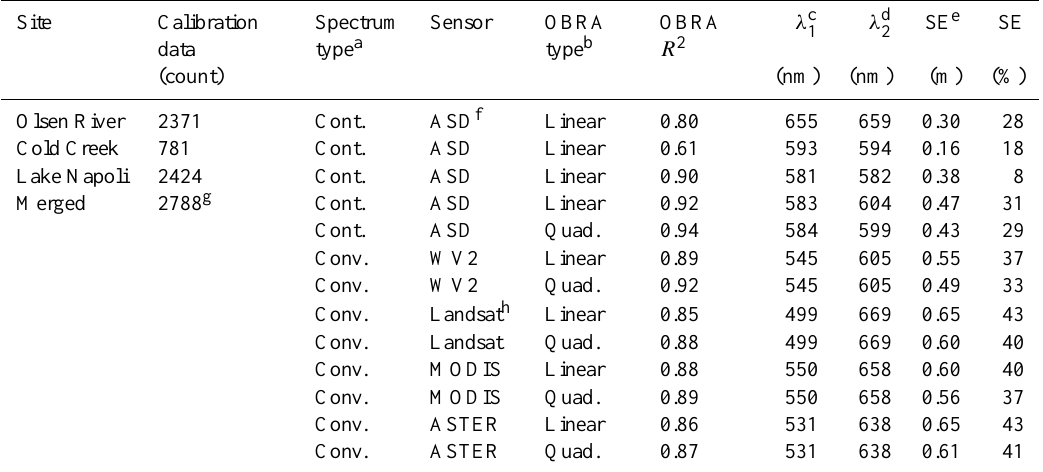
Table 2. Summary of optimal band ratio analysis (OBRA) of field spectra and depth measurements from three field sites on the surface of the GrIS and for the merged data set aggregated over the three